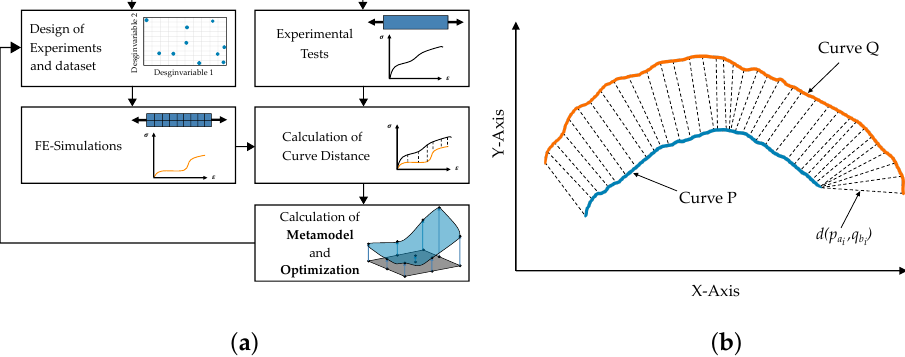
Figure 6. Metamodel-based iterative optimization methodology for PI identification ( a ) and curve distance measurement algorithm dynamic time warping ( b